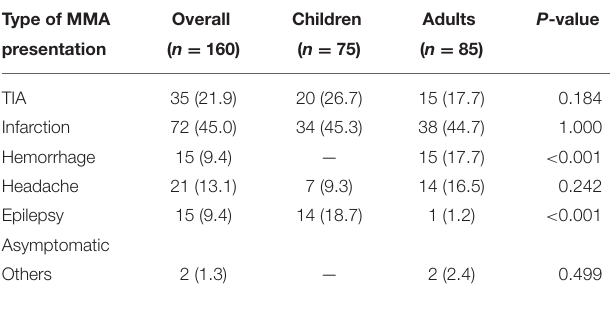
TABLE 5 | Frequency of type of MMA presentation.